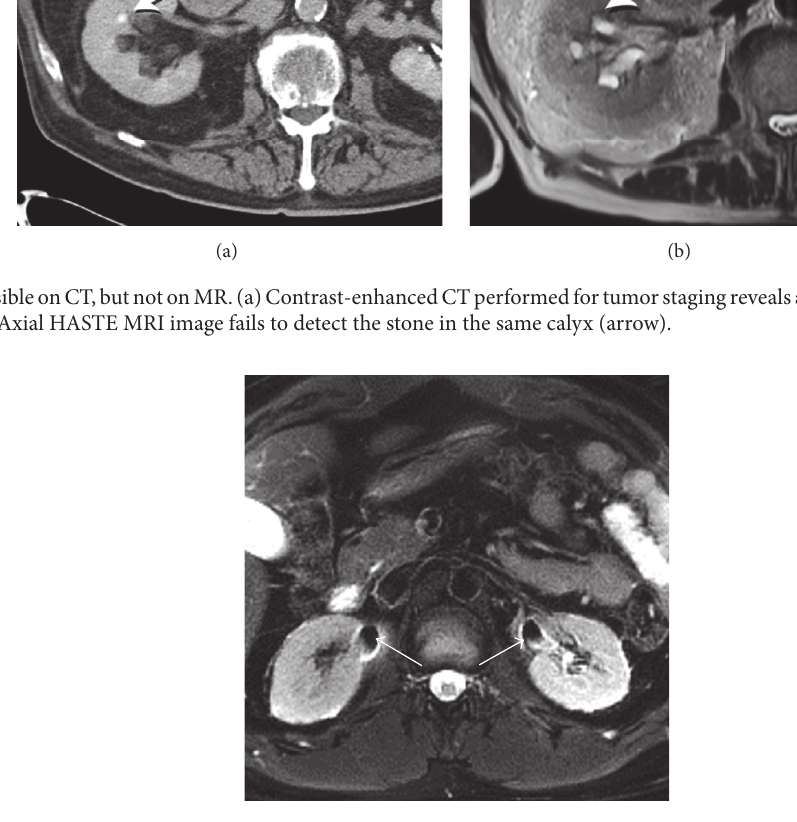
Figure 3: MRI artifacts mimicking kidney stones. An MRI image showing signal void due to T 2 ∗ artifact from concentrated gadolinium in both collecting systems (arrows). These signal voids could readily be mistaken for